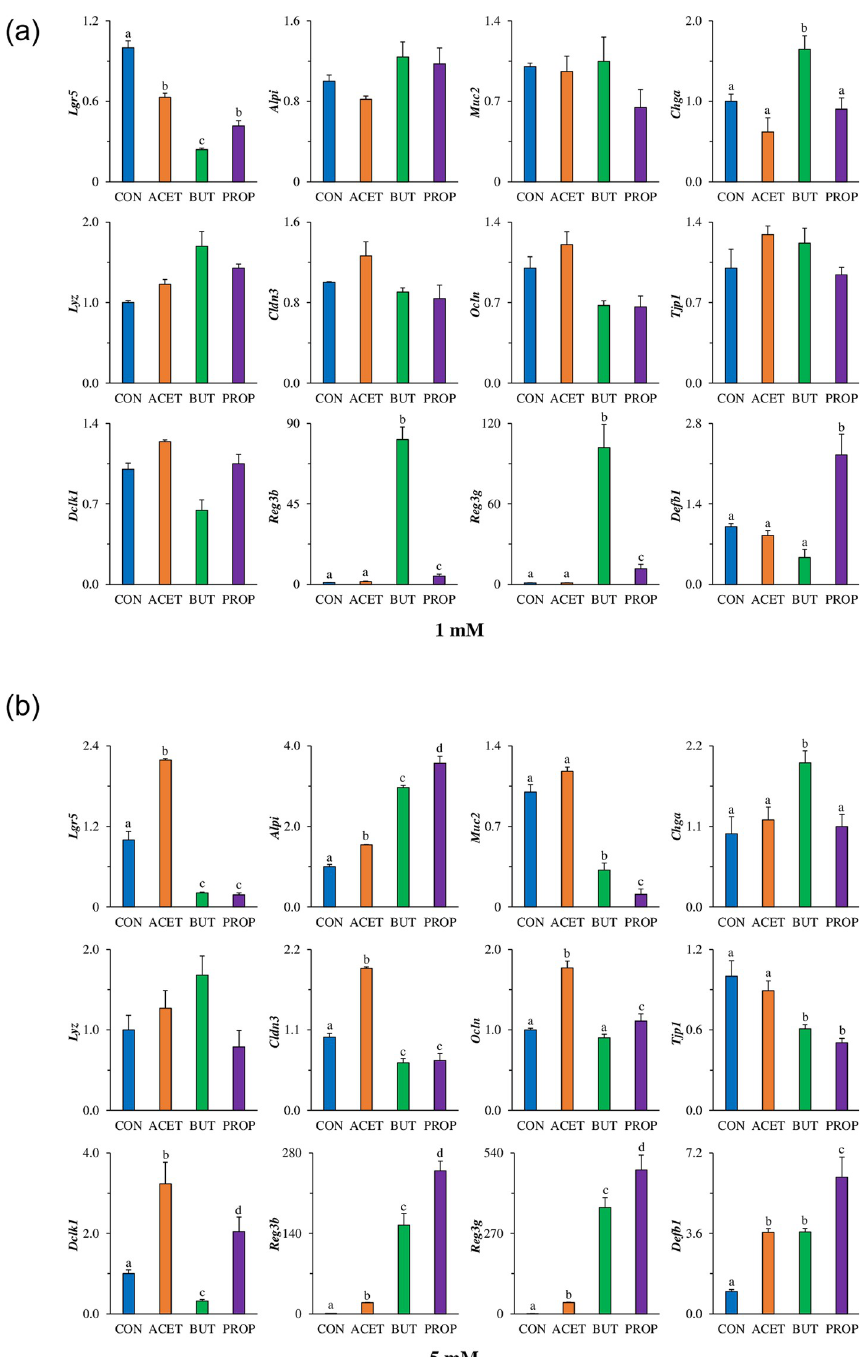
Fig 2. Mouse enteroids treated with single SCFAs alters gene expression after 24h. Effect of 24 h treatment with acetate (ACET), butyrate (BUT), or propionate (PROP) at (A) 1 mM and (B) 5 mM. Gene expression of differentiation markers: stem cells ( Lgr5) , enterocyte alkaline phosphatase ( Alpi ), goblet cell mucin 2 ( Muc2 ), enteroendocrine cell chromogranin A ( Chga ), Paneth cell lysozyme ( Lyz ), tight junction markers claudin-3 ( Cldn3 ), occludin ( Ocln ), zonula-occludens 1 ( Tjp1 ), Tuft cell marker Dclk1 , anti-microbial peptide expression Reg3 β , Reg3 γ , and beta-defensin 1 ( Defb1 ) were analyzed in murine 3D duodenal enteroids. Treatments are compared to controls (CON) which are set to 1.0 and superscripts (a,b,c,d) indicate statistical significance between treatments at P < 0.05, n = 4.